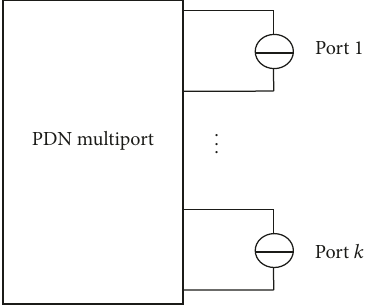
Figure 3: Example of PDN with